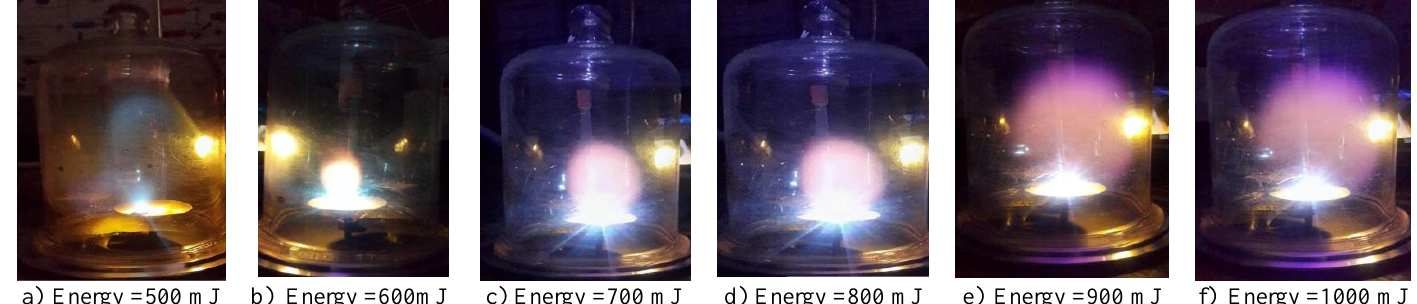
Fig. 5: Plume plasma for CuO:Pb component At X=0.6 target in vacuum with different laser energies.